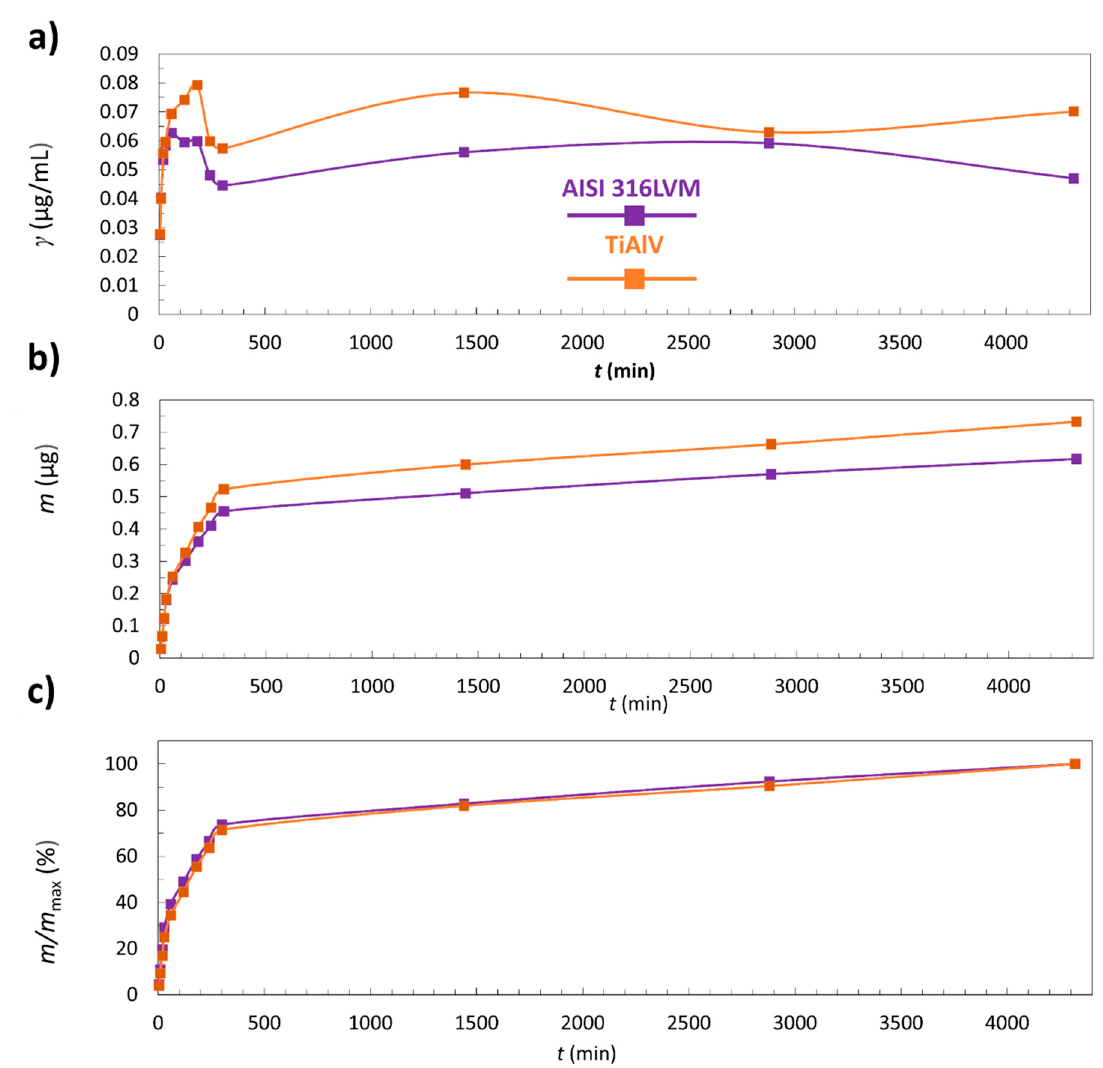
Figure 7. Results from the in vitro CLIN release testing of the 3D-printed coatings on AISI 316LVM and TiAlV: ( a ) the concentration of the released CLIN as a function of time ( b ) the cumulative mass of the released CLIN as a function of time, and ( c ) the mass fraction of the released CLIN as a function of time.